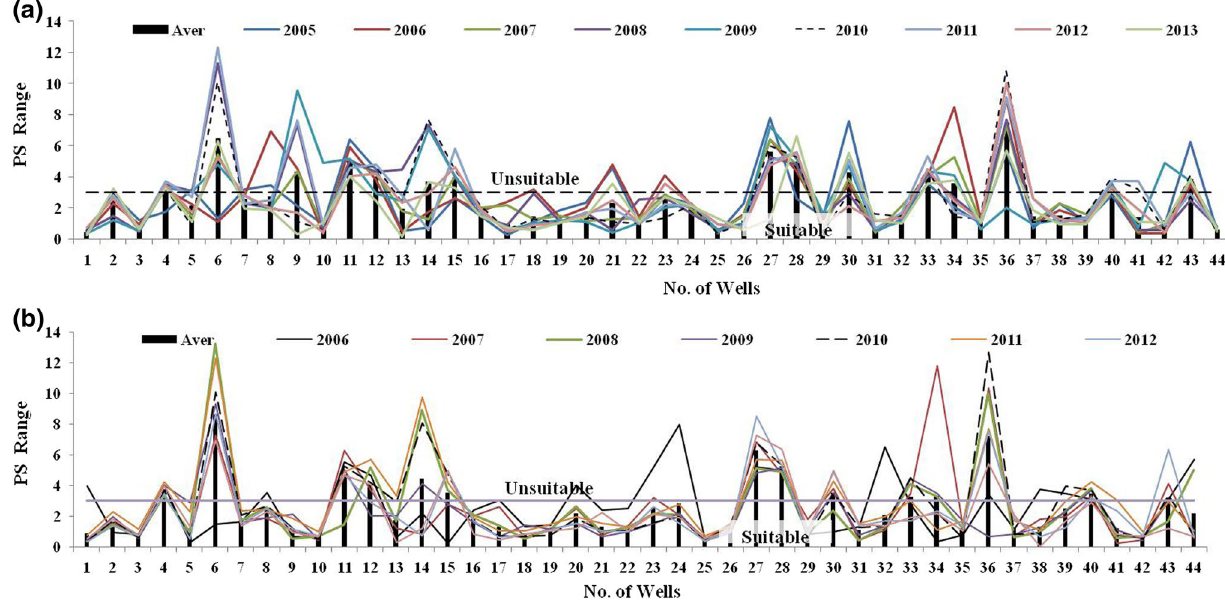
PS value during